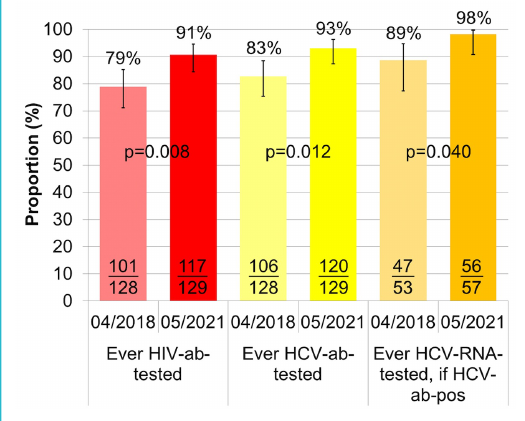
Figure 1: Proportion of patients ever HIV/HCV-antibody-tested and proportion of HCV-antibody-positive patients ever HCV-RNA- tested. HCV: hepatitis C virus; HIV: human immunodeficiency virus; ab: antibody; RNA = ribonucleic acidThe error bars show the lower and upper limit of the 95% confidence interval (Score [Wil- son]).